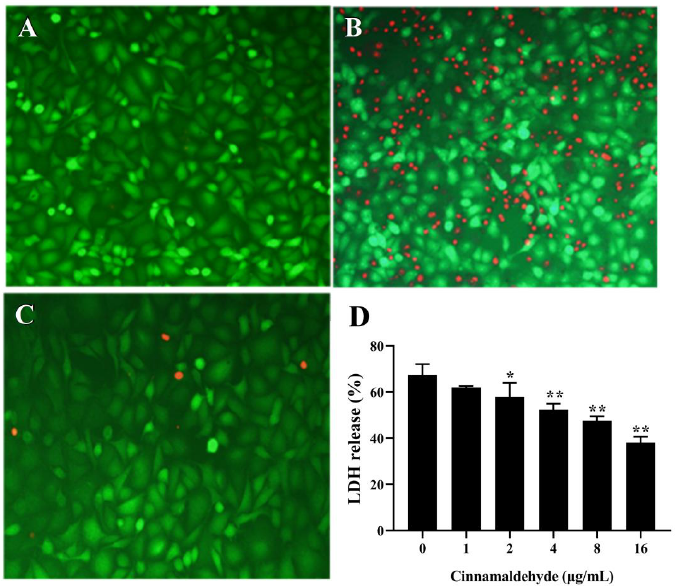
Figure 7. The protective effect of cinnamaldehyde on aerolysin-mediated cell injury. ( A ) Untreated cells; ( B ) cells treated with drug-free supernatant; ( C ) cells treated with 16 μg/mL cinnamaldehyde-treated bacterial supernatant; ( D ) LDH release of A549 cells co-cultured with cinnamaldehyde-treated bacterial supernatants; LDH assay was performed in triplicate; data were mean value ± SD. *, 0.01 < p < 0.05 and **, p < 0.01.